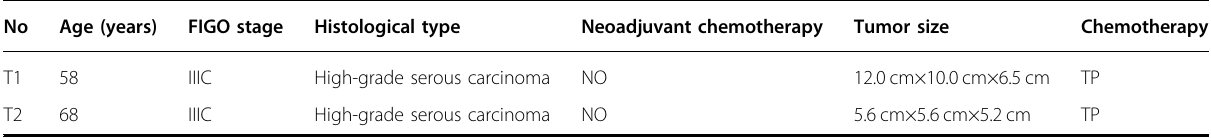
FIGO International Federation of Gynecology and Obstetrics, TP , chemotherapy based on paclitaxel and